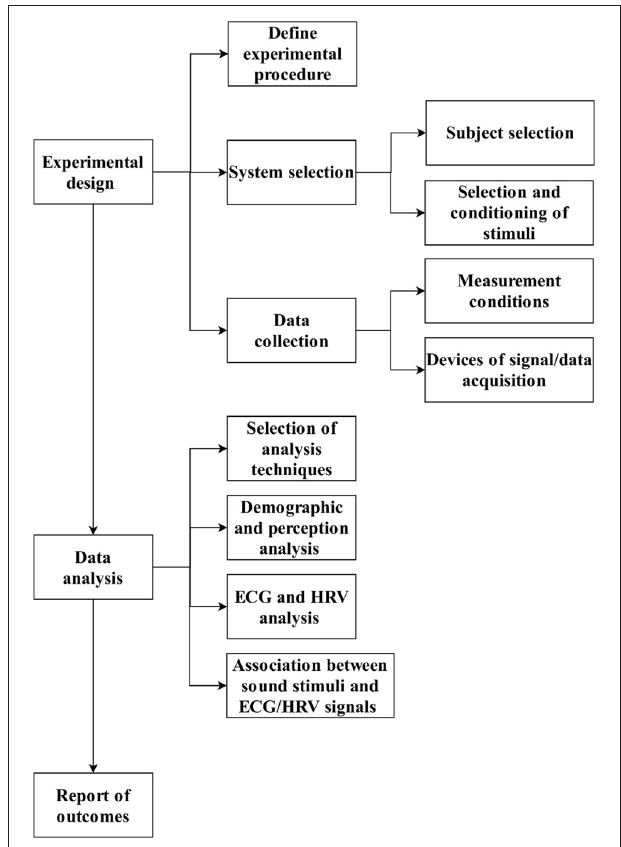
FIGURE 1 | Block diagram of